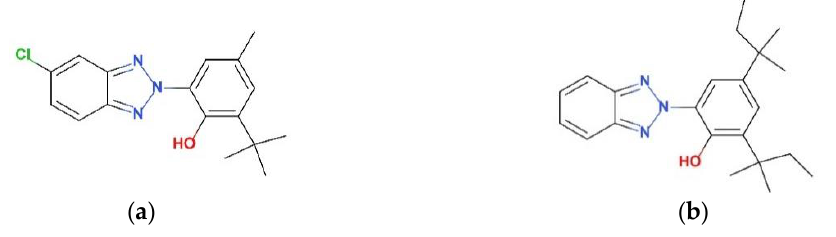
Figure 1. Chemical structures of ( a ) UV-326 and ( b ) UV-328.